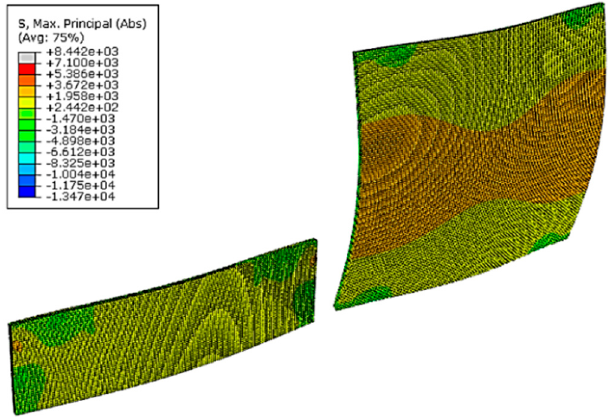
Figure 12. Examples of finite element model (FEM) simulations of marble stone slabs and stress distribution associated to wind pressure for serviceability limit sates (SLS) characteristic combination (values in ×10 3 Pa).